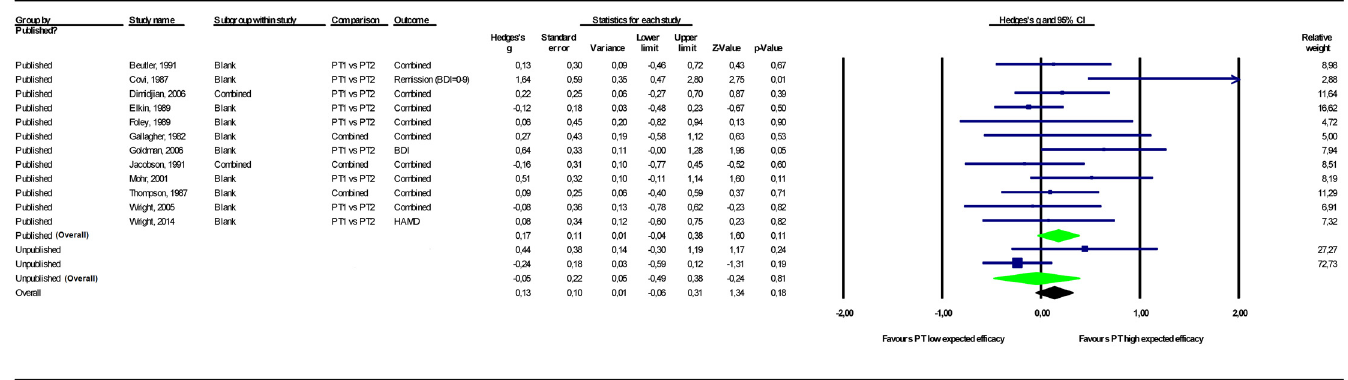
Fig 5. Psychological treatment versus other psychological treatment. Note: Not all results of the unpublished studies are presented at study level, because we did not have permission of the investigators to do so. BDI = Beck Depression Inventory; HAMD = Hamilton Depression Rating Scale; PT = psychological